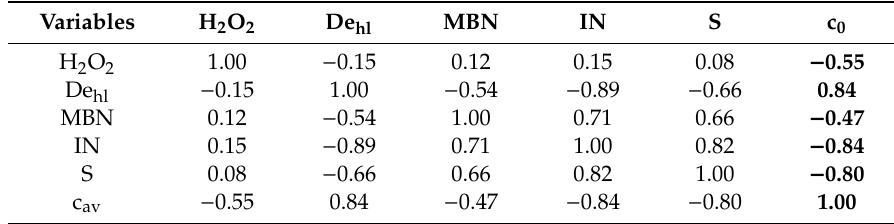
Bolded text—statistically significant correlations; c av —average dye concentration. Table 6. Spearman’s rank correlation between the mean concentration of phenol red as well as the characteristics of activated carbon and the dose of employed oxidizer.